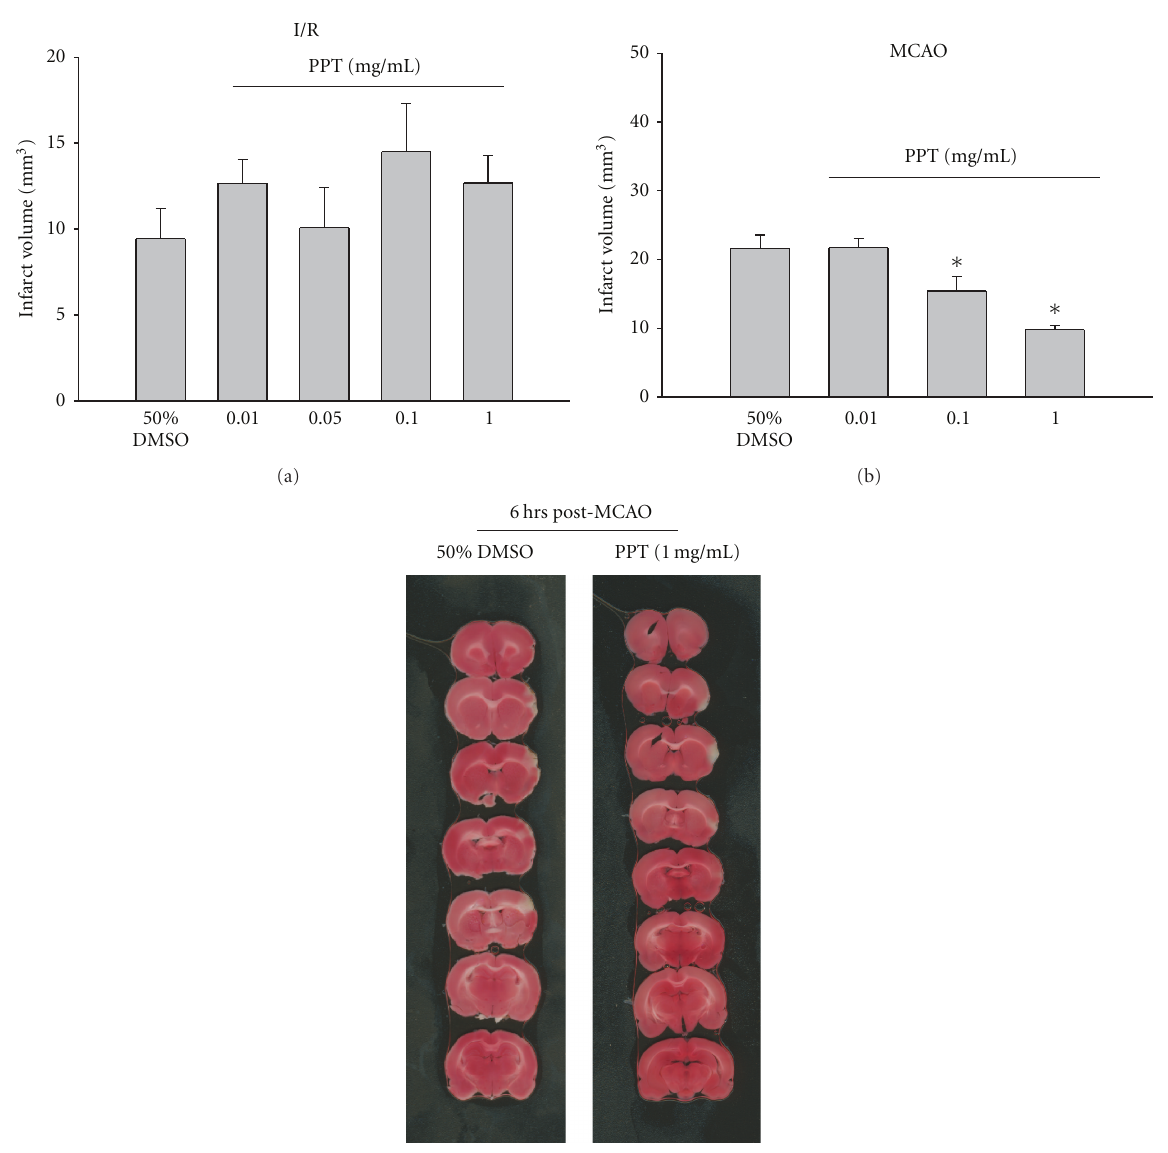
Figure 1: E ff ect of pretreatment with either 50% DMSO or PPT (i.v.; 30 minutes) on infarct volume (mm 3 ) calculated from TTC-stained 1mm thick coronal sections throughout the extent of the infarct following I/R (a) and MCAO (b). Each bar represents the mean ± S.E.M ( n = 4–6/group), and ∗ indicates significance ( P ≤ . 05) from the DMSO control group. (c) Representative photomicrographs of TTC stained, 1mm thick coronal slices illustrating the extent of the infarct within the prefrontal cortex following 30 minutes pretreatment (i.v.) with either DMSO or PPT (1mg/kg) at 6 hours